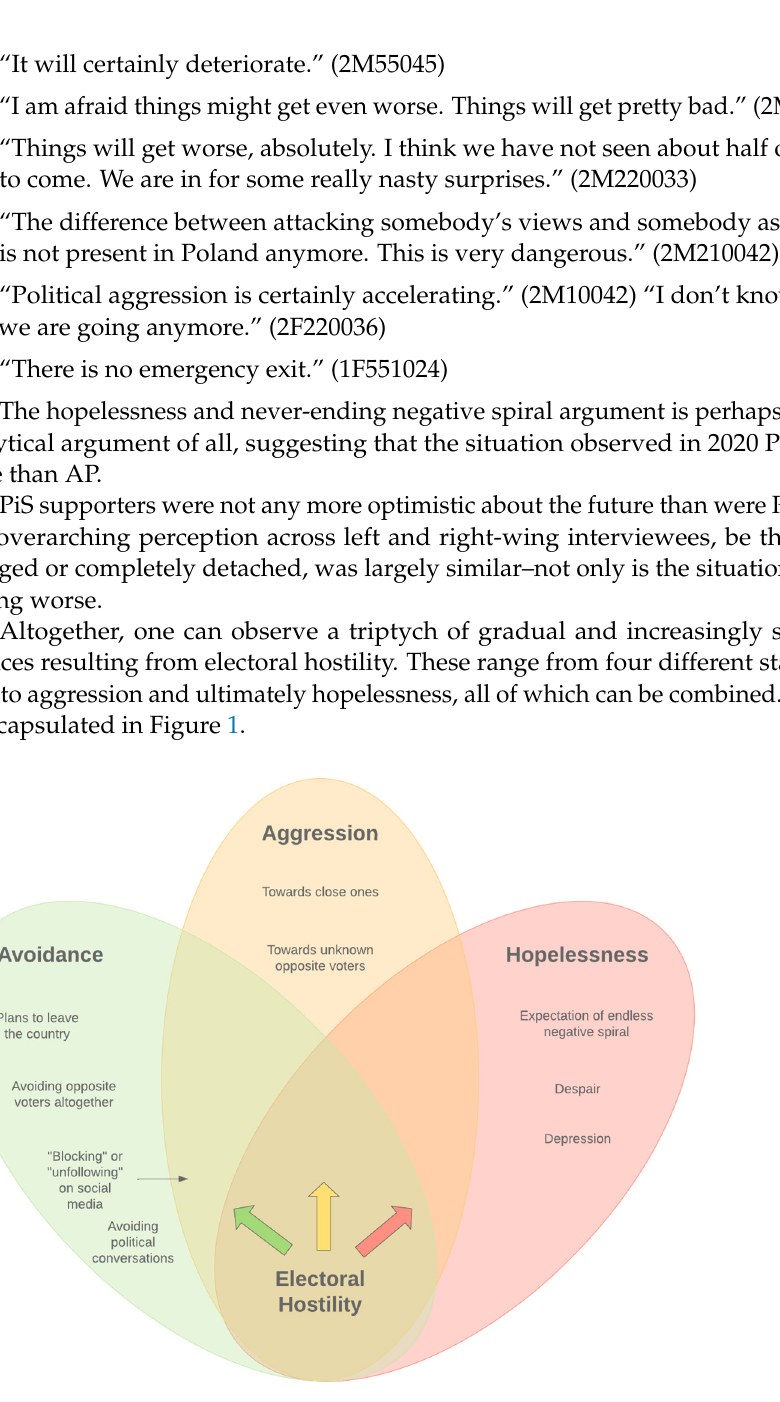
Figure 1. Consequences of